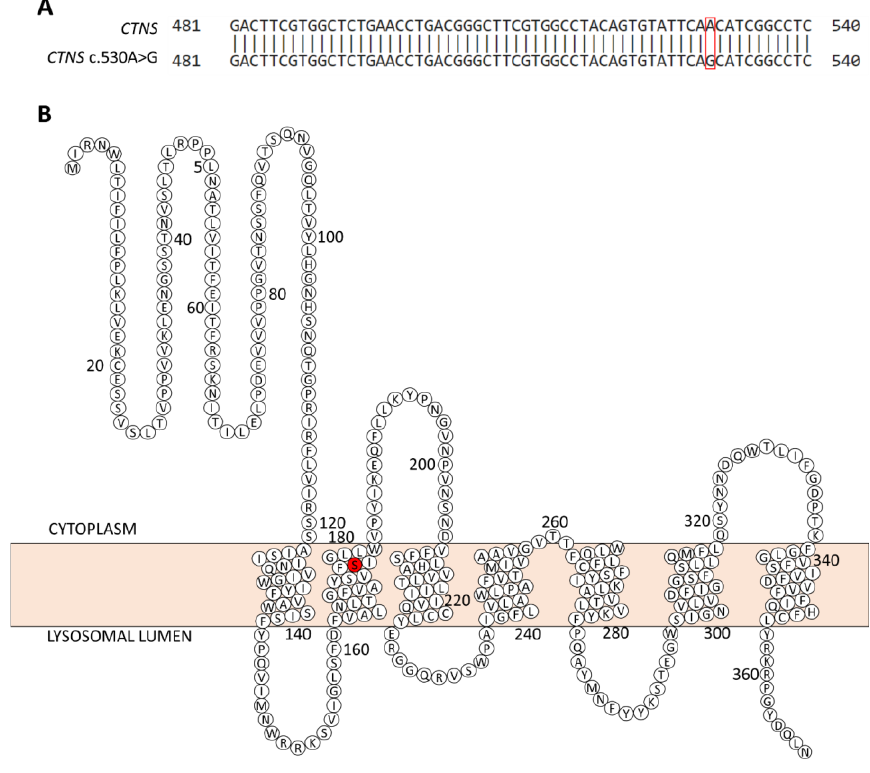
Figure 2. ( A ) A missense mutation (c. 530 A > G, red square) results in ( B ) an amino acid substitution (p. Asn177Ser, red) in the second transmembrane region of cystinosin. Adapted from [23]. Inheritance was confirmed by subsequent genetic analysis on the mother and father of the patient, revealing the heterozygous c.530A > G (p.Asn177Ser) mutation in CTNS 8 in both